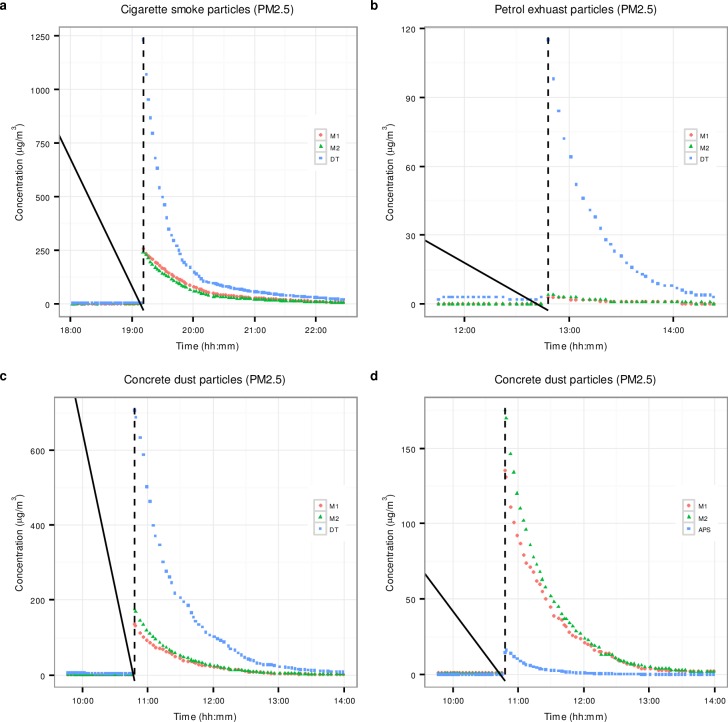
Time series of PM2.5 concentrations measured during chamber experiments.a) Cigarette smoke particles measured by M1, M2 and DustTrak. b) Petrol exhaust particles measured by M1, M2 and DustTrak. c) Concrete dust particles measured by M1, M2 and DustTrak. d) Concrete dust particles measured by M1, M2 and APS. The black dotted vertical lines indicate the times at which the particles were introduced into the chamber.